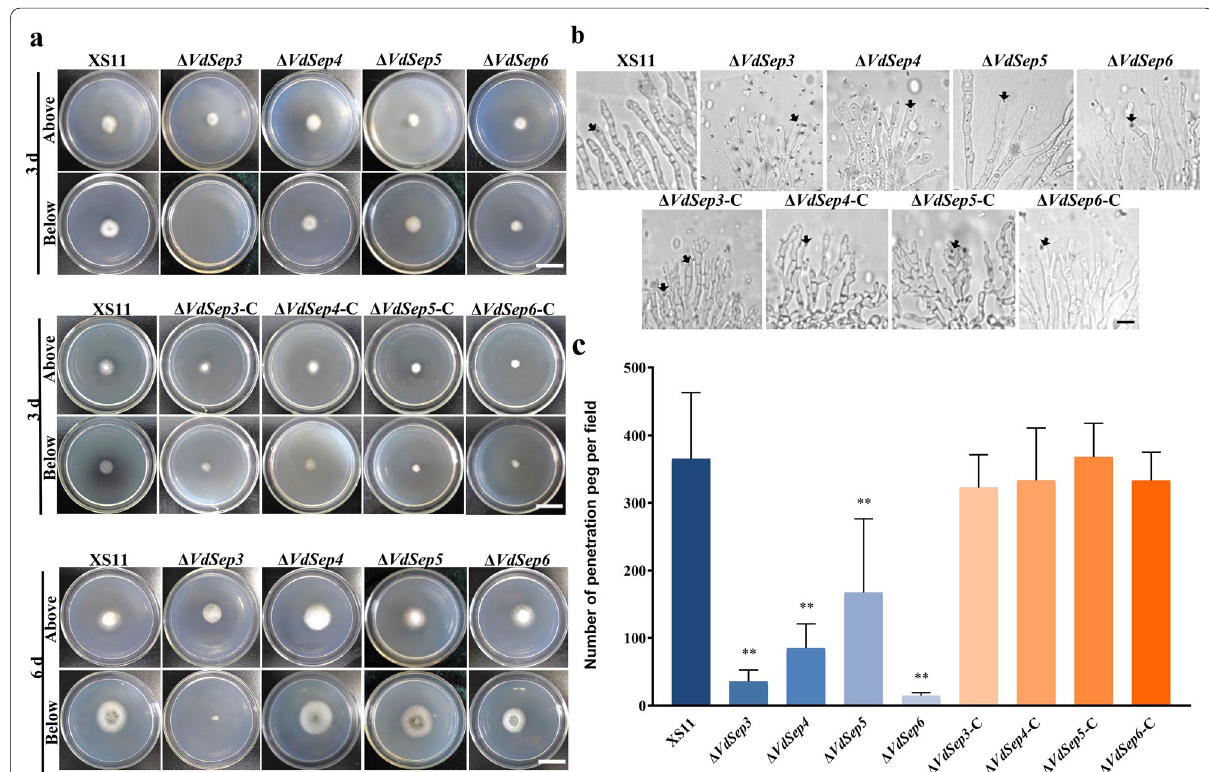
Fig. 5 Penetration peg formation on cellophane. a Colonies of XS11 and mutants (Δ VdSep3 , Δ VdSep4 , Δ VdSep5 , and Δ VdSep6 ) grown on minimal medium (MM) overlaid with (upper panel) or without a cellophane membrane (lower panel). The strains were grown on MM plates overlaid with a cellophane membrane at 25 °C for 3 days or 6 days, and incubated for another 3 days after the membrane was removed. Bar 2 cm. b Hyphopodia = and penetration pegs formed on a cellophane membrane at 6 dpi. Bar 10 μm. c Column diagram showing the number of penetration pegs = formed by each strain on cellophane. The error bars represent standard deviations based on three independent replicates (**, P <